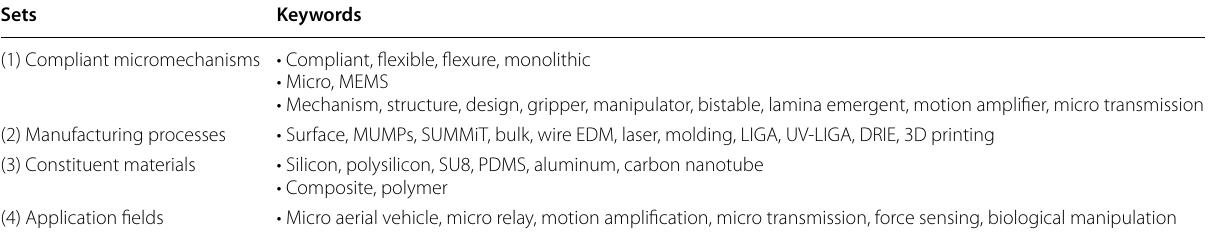
Table 1 Overview of the sets of keywords used in the literature survey